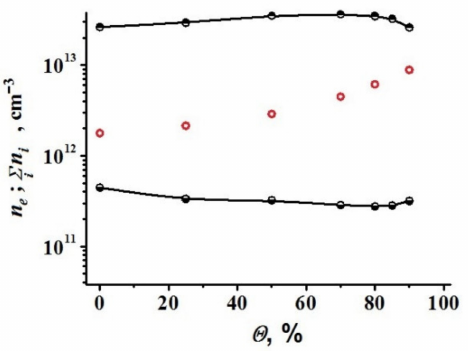
Figure 17. Dependences of the stationary values of the total concentration of ions (upper curve) and electrons (lower curve) on the volume fraction of argon introduced into the discharge. The curves are calculated taking into account the charge of solid particles. Hollow circles denote the equilibrium concentrations n e = ∑ n i obtained in calculations for the same power without taking into account the charge of solid particles. The power absorbed in the discharge is 50 W.